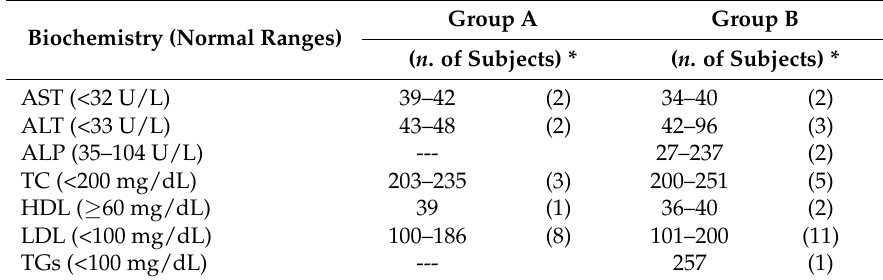
Table 3. Range of values of liver biochemical parameters outside the normal ranges observed during the multiple dose phase in both treatment groups—ITT population. Group A Group B Biochemistry (Normal Ranges) ( n . of Subjects)